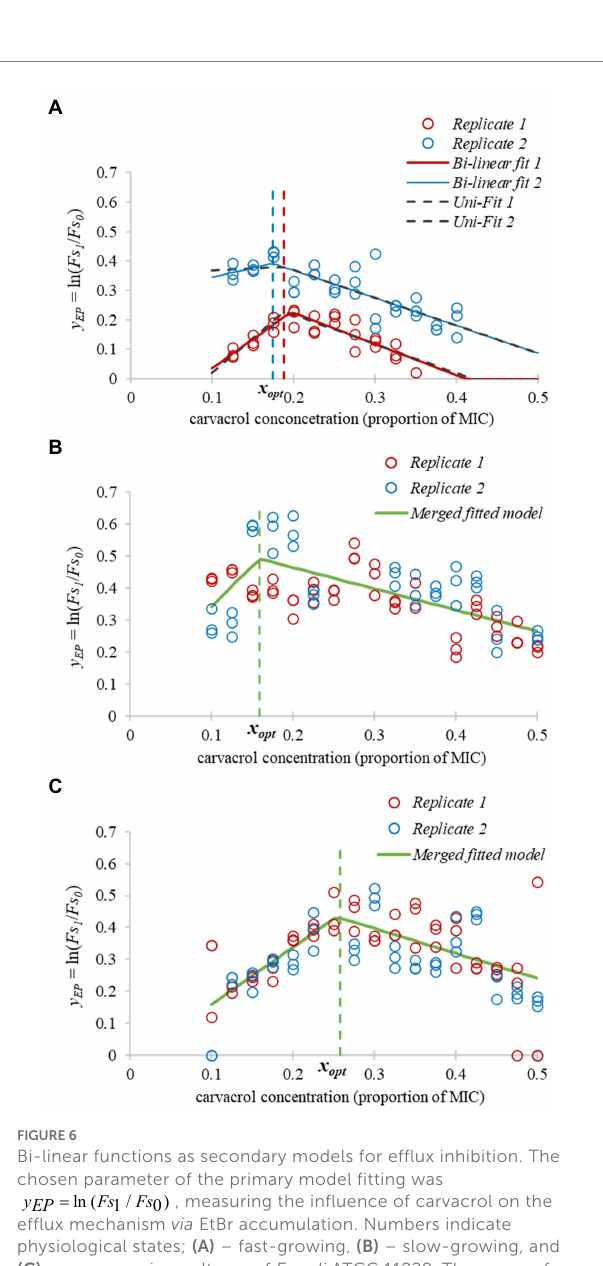
FIGURE 7 Linear function fitted to the secondary model of membrane integrity readings according to different concentrations of carvacrol for non- growing cultures of E. coli VF 3584.